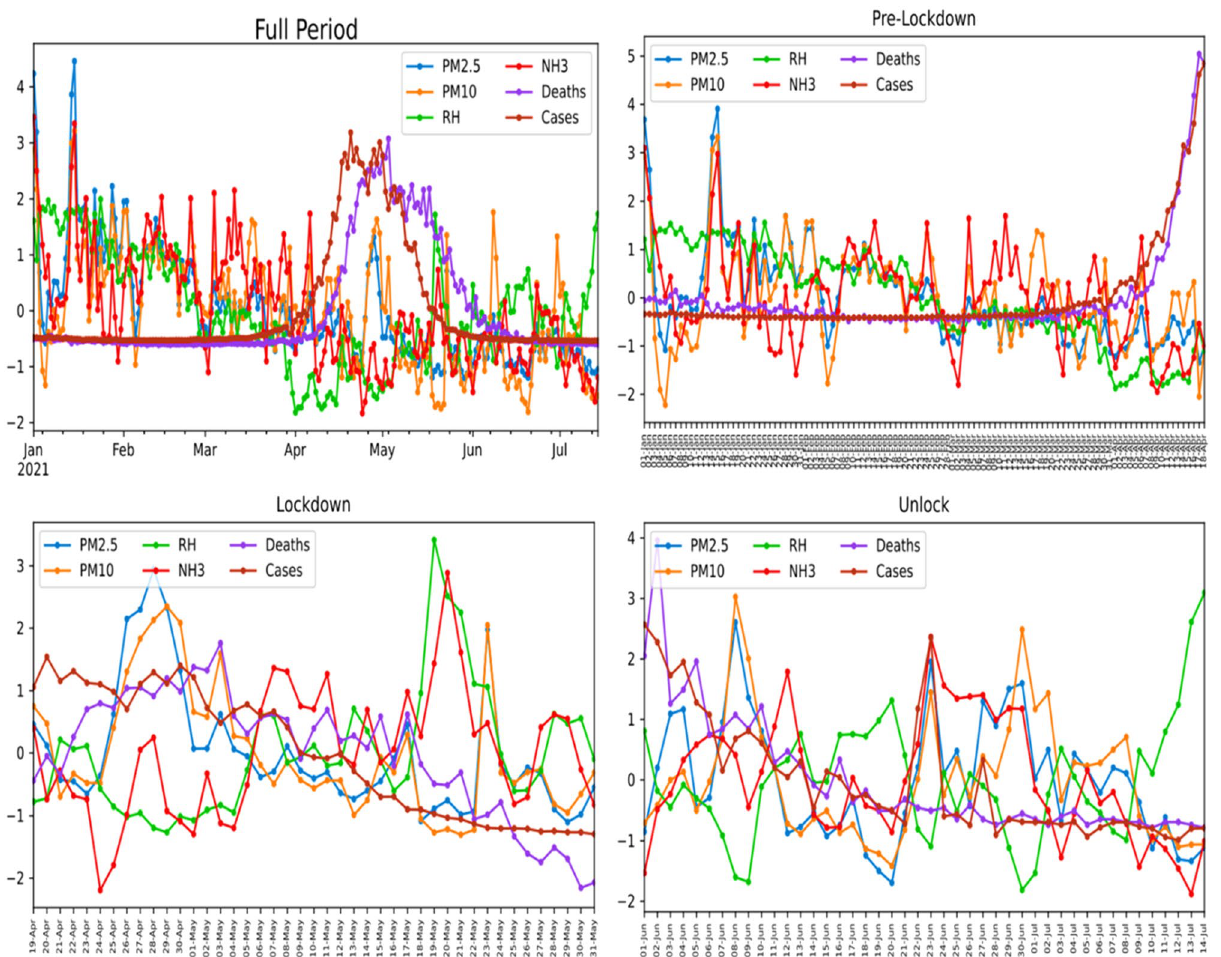
Figure 6. Variation of normalized variables with time for full period, pre-lockdown period, lockdown period, and unlock period.